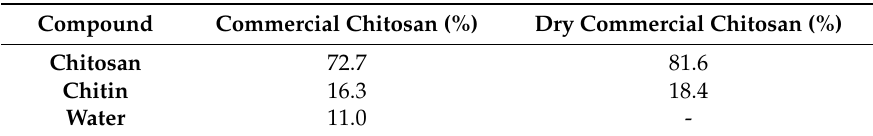
Table 3. Commercial chitosan composition.